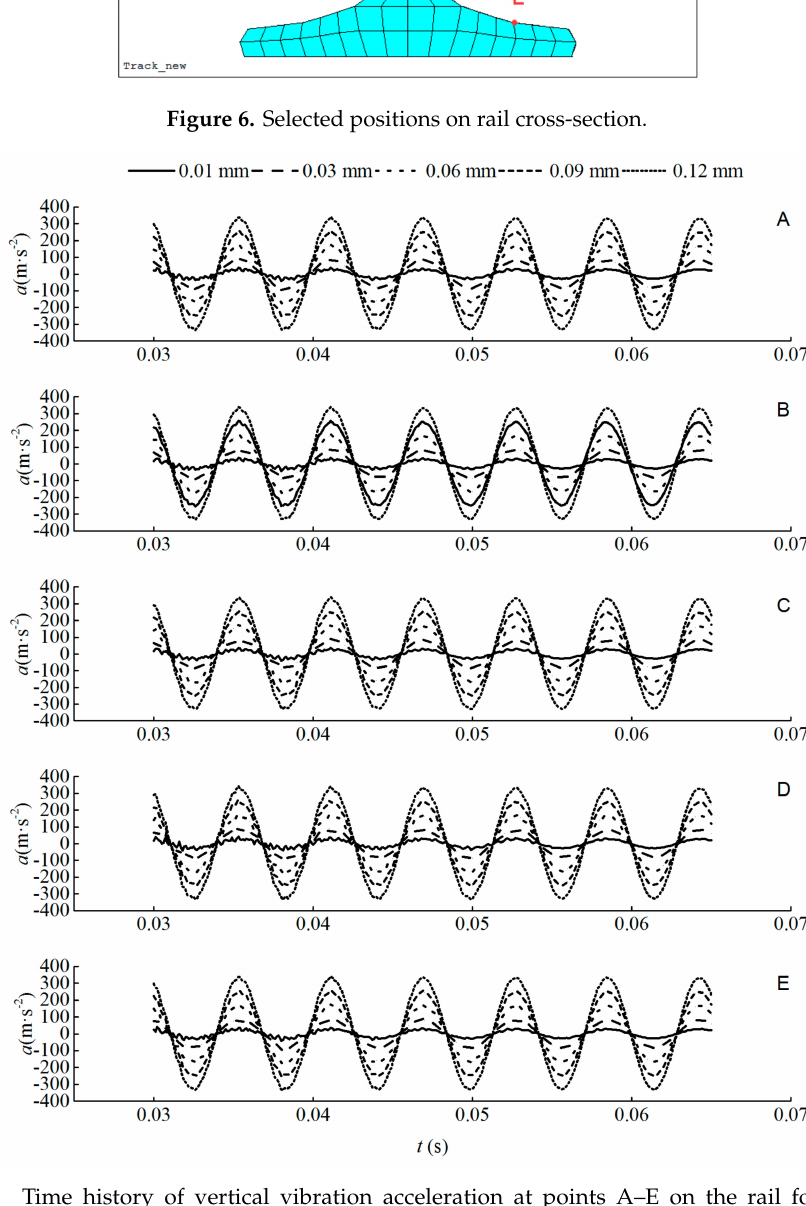
Figure 7. Time history of vertical vibration acceleration at points A–E on the rail for various out-of-roundness (OOR) amplitudes at a train speed of 300 km /